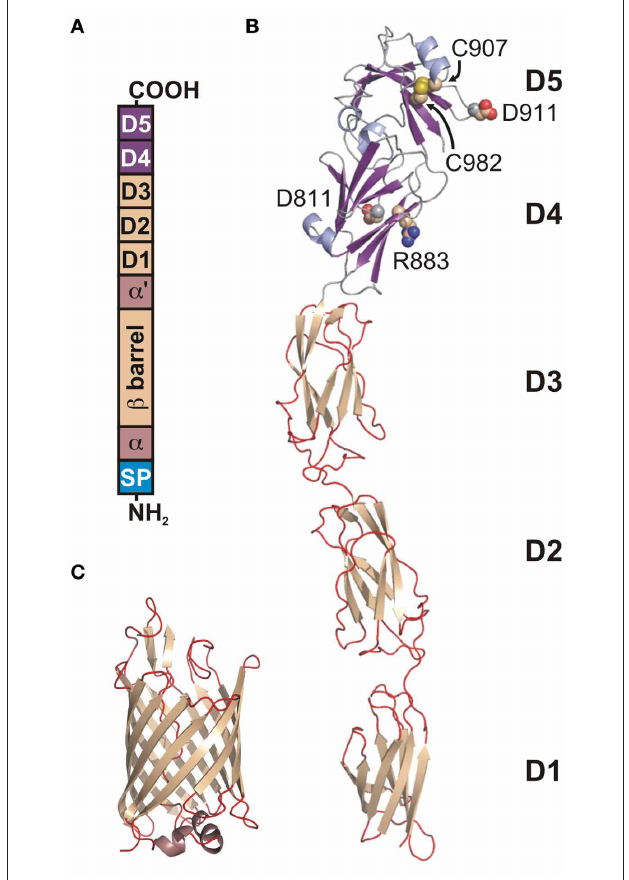
FIGURE 2 | Modular architecture of the Y. pseudotuberculosis invasin. (A) A schematic topology model of preprotein. From N-terminus: (SP) signal peptide, (a) periplasmic hydrophilic α -domain, ( β -barrel) OM embedded β -barrel domain, ( α ’) periplasmic hydrophilic α ’-domain, (D1–D4) extracellular Ig-like domains, (D5) extracellular distal domain of the C-type lectin-like fold. D4 and D5 form a functional integrin binding module. (B) Ribbon diagram of the structure of D1–D5 (1CWV). Residues D811, R883, C907, D911, and C982 (space-filling representation) are implicated in integrin binding. (C) Ribbon diagram of the β -barrel structure